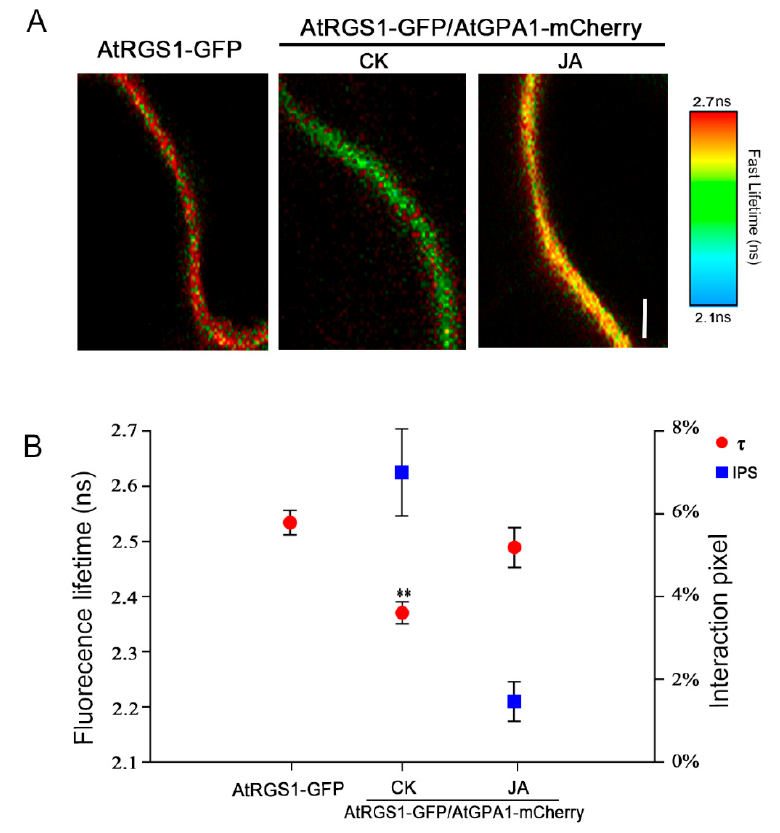
Figure 4. JA induces the dissociation of AtRGS1 from AtGPA1. ( A ) Fluorescence lifetime heat maps of AtRGS1-GFP alone or AtRGS1-GFP/AtGPA1-mCherry in N. benthamiana leaves prior and after MeJA treatment for 8 h. Bar = 10 μ m. The scale varies from lowest lifetime of 2.1 s to the highest lifetime of 2.7 s. ( B ) The average fluorescence lifetime ( τ ) and FRET efficiency (IPS) of AtRGS1-GFP alone or AtRGS1-GFP/AtGPA1-mCherry in N. benthamiana leaves prior and after MeJA treatment for 8 h. Error bars represent SD ( n = 9–12). Significant differences are denoted by letters (** p < 0.01, Student’s t test).